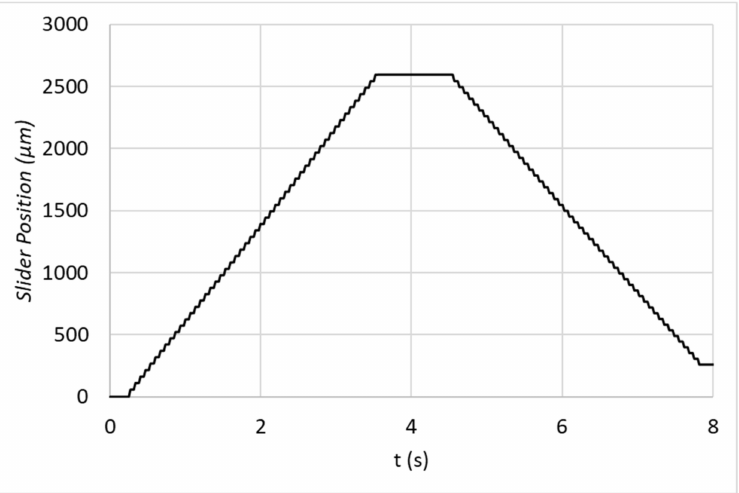
Figure 12. Slider position when 100 driving pulses are sent to the receiver coil for 50 times in one direction and again 50 times in the reverse direction. A direction-dependent step size difference is visible in this measurement